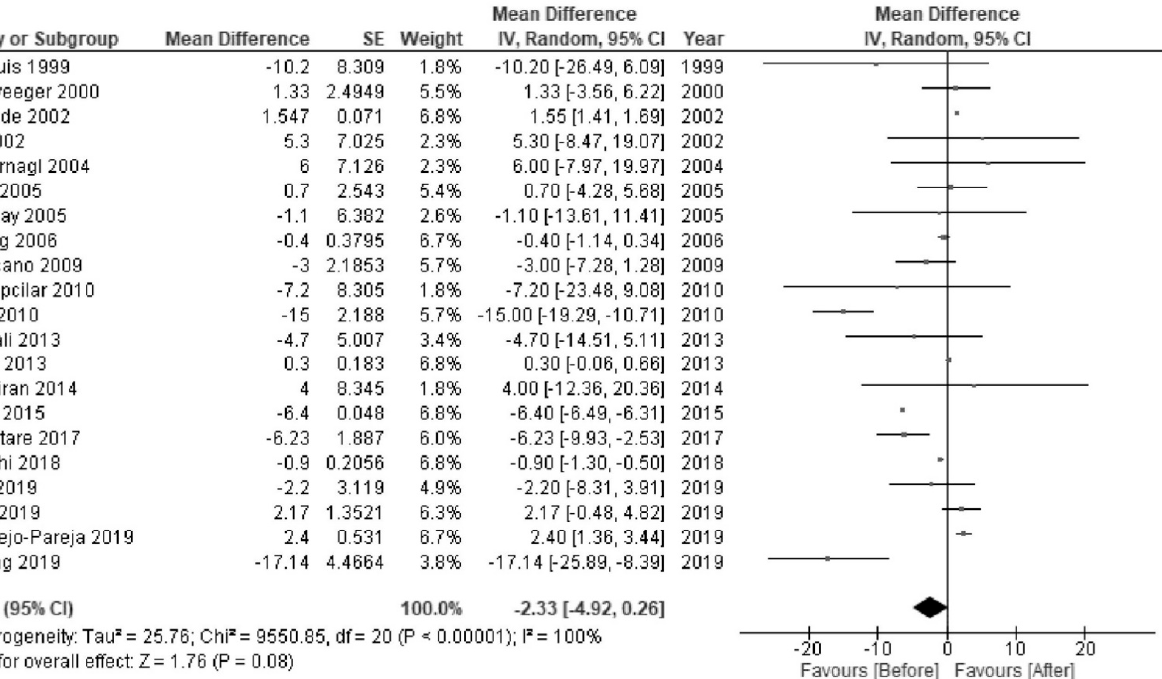
Figure 5. Forest plot of the mean changes in total cholesterol levels before and after Helicobacter pylori eradication.